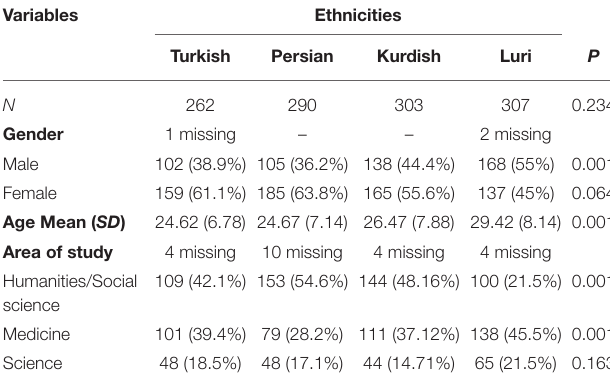
TABLE 1 | Demographic